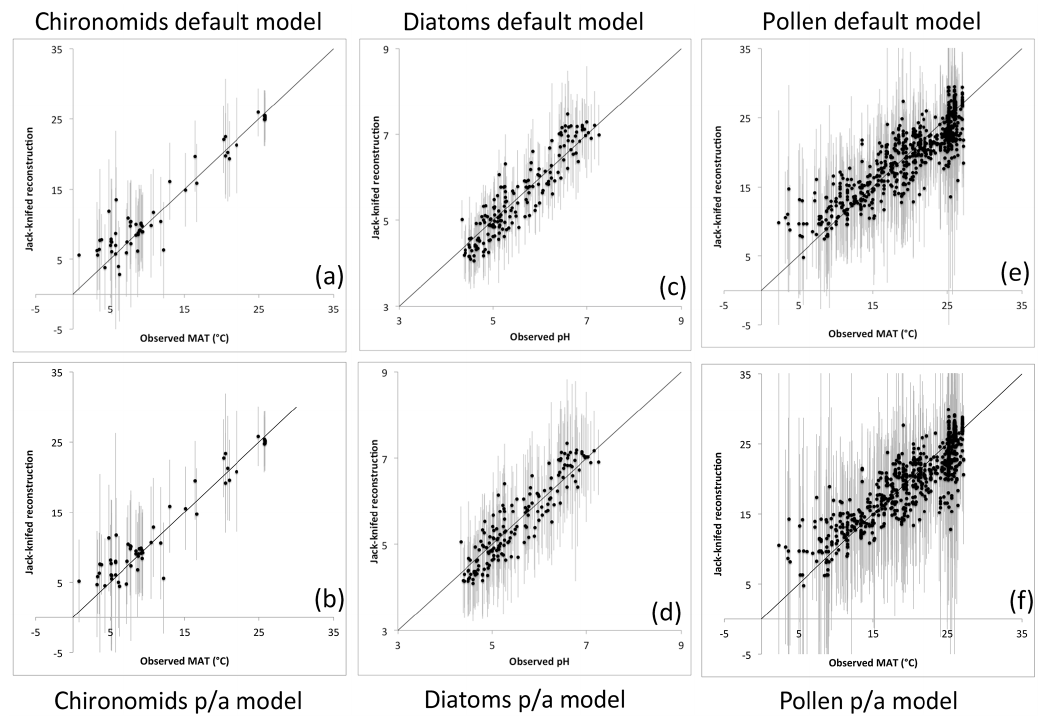
Figure 3. Cross-validated reconstructions (Eq. 8) together with associated uncertainty ± 2 (cid:49) (Eq. 9) are plotted against observed training-set environments for each of the three training sets (Matthews-Bird et al., 2016; Stevenson et al., 1991; Bush et al., 2017). We plot the default model ( η = 0 . 5 ) and the presence–absence model ( p/a ) ( η = 1 . 0 ) . All analyses impose the constraint that 2% abundance is required for